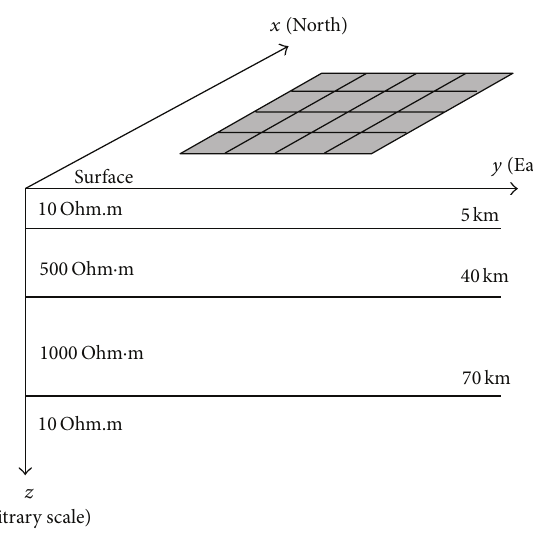
Figure 1: A heterogeneous superficial thin-sheet model embedded in 1D or layered host medium. The resistivities and thicknesses are arbitrary, for the illustration purpose